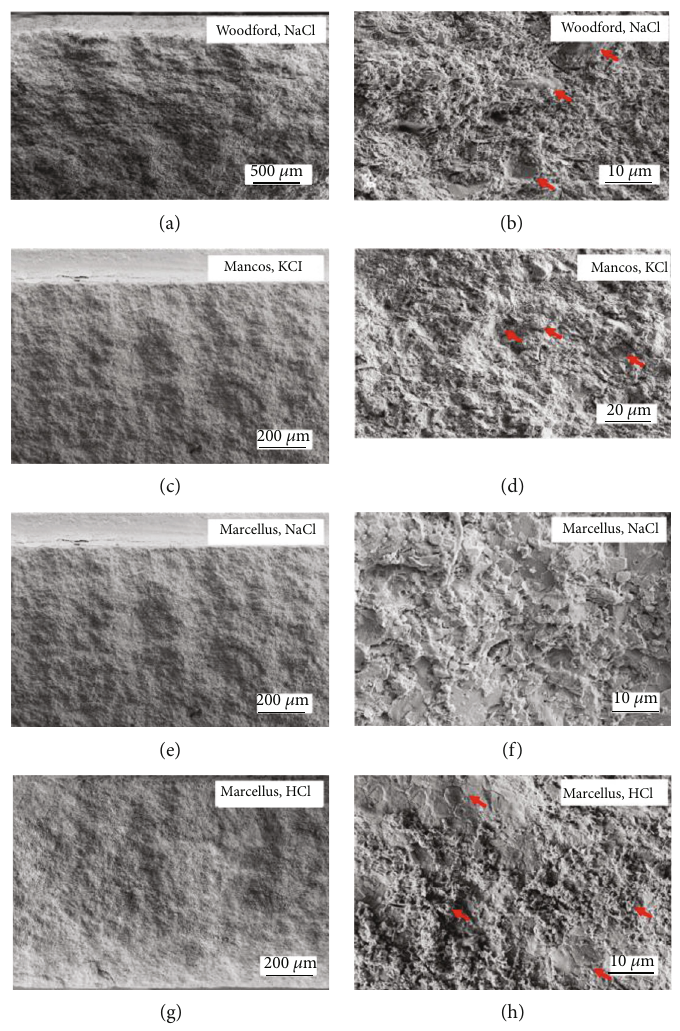
Figure 18: Fracture surfaces in the tests conducted by Chen et al.